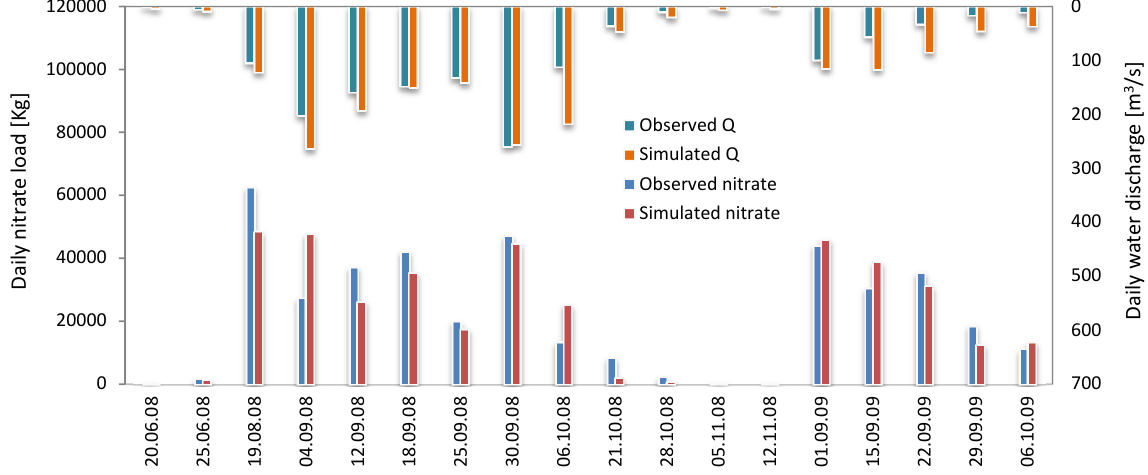
Figure 5. Simulated vs. observed daily nitrate load for Atchérigbé sub-catchment (6978 km 2 ). Calibration period was 2008 (R 2 = 0.86 and ME = 0.81), validation period was 2009 (R 2 = 0.62 and ME = 0.54).